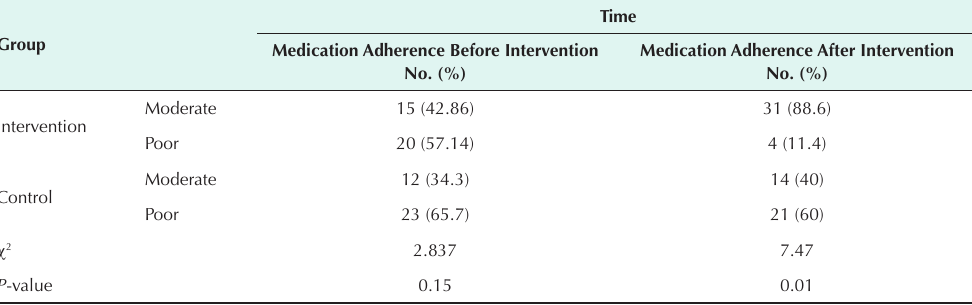
Table 3. The Frequency of Good and Poor Medication Adherence Before and After the Study in Both Groups